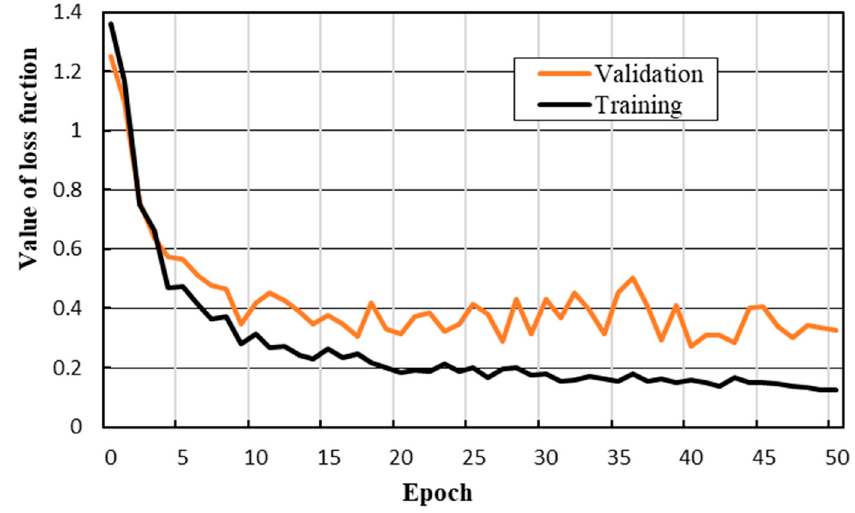
Figure 10. The loss value curve of the training and validation processes.